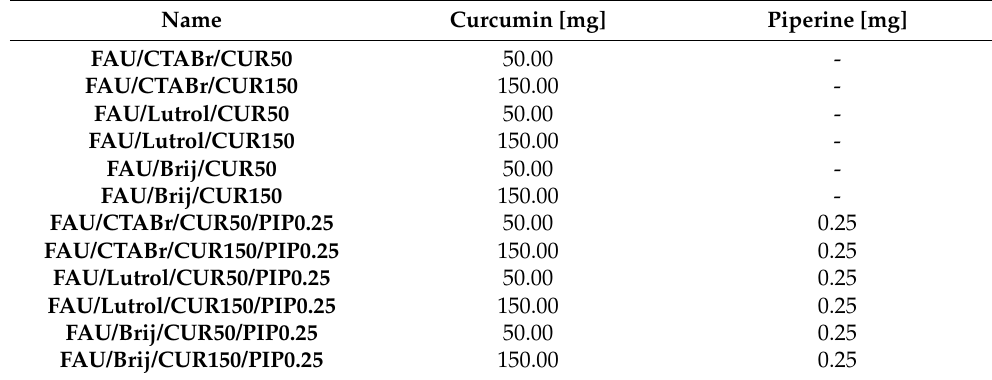
Table 1. Optimization of experimental conditions for incorporating curcumin into hierarchical